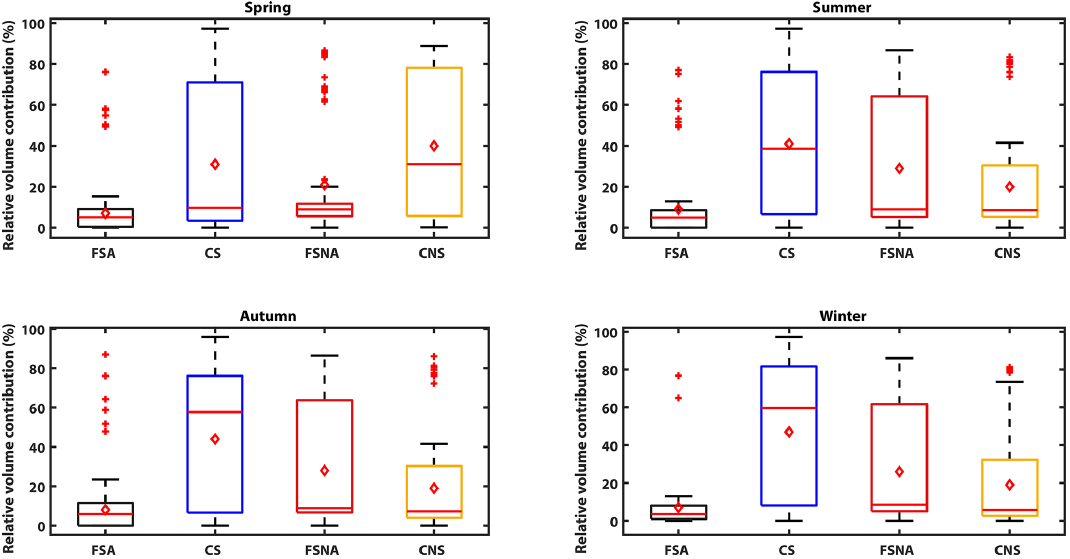
Figure 10. Seasonal statistics of the relative volume contribution of the different aerosol components. Minimum and maximum values are indicated by the lower and upper whisker, median and mean values by the red lines and rhombuses, respectively. The lower part of each box indicates the 25% percentile and the upper part the 75% percentile. Red crosses show the